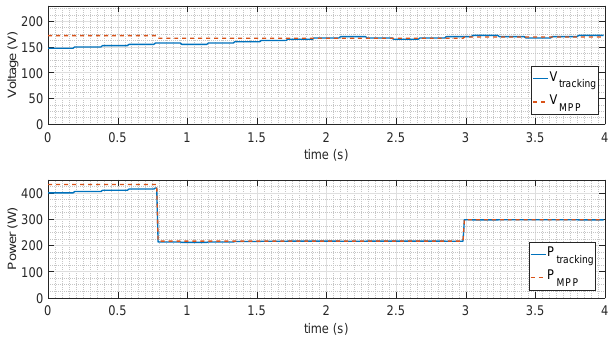
Figure 26. Tracking profile of INC under sudden irradiance changes.